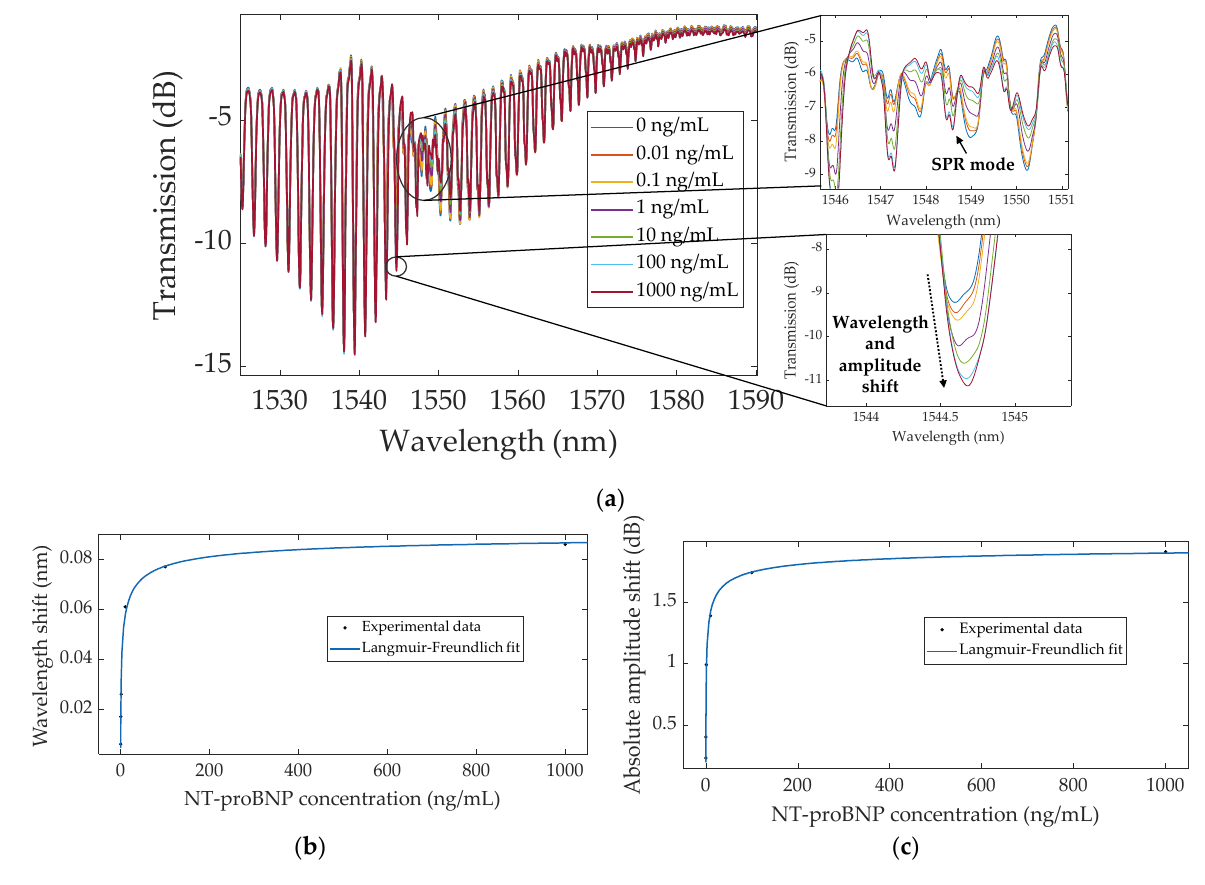
Figure 7. ( a ) Spectral evolution of the biofunctionalized Au–TFBG, recorded in PBS, before (0 ng/mL) and after incubation in each concentration of NT-proBNP (0.01–1000 ng/mL), zooming in on the SPR mode (top inset) and the most sensitive mode around 1544 nm (bottom inset); ( b ) wavelength and ( c ) absolute amplitude shifts as a function of concentration, with the Langmuir–Freundlich fitting to the data.